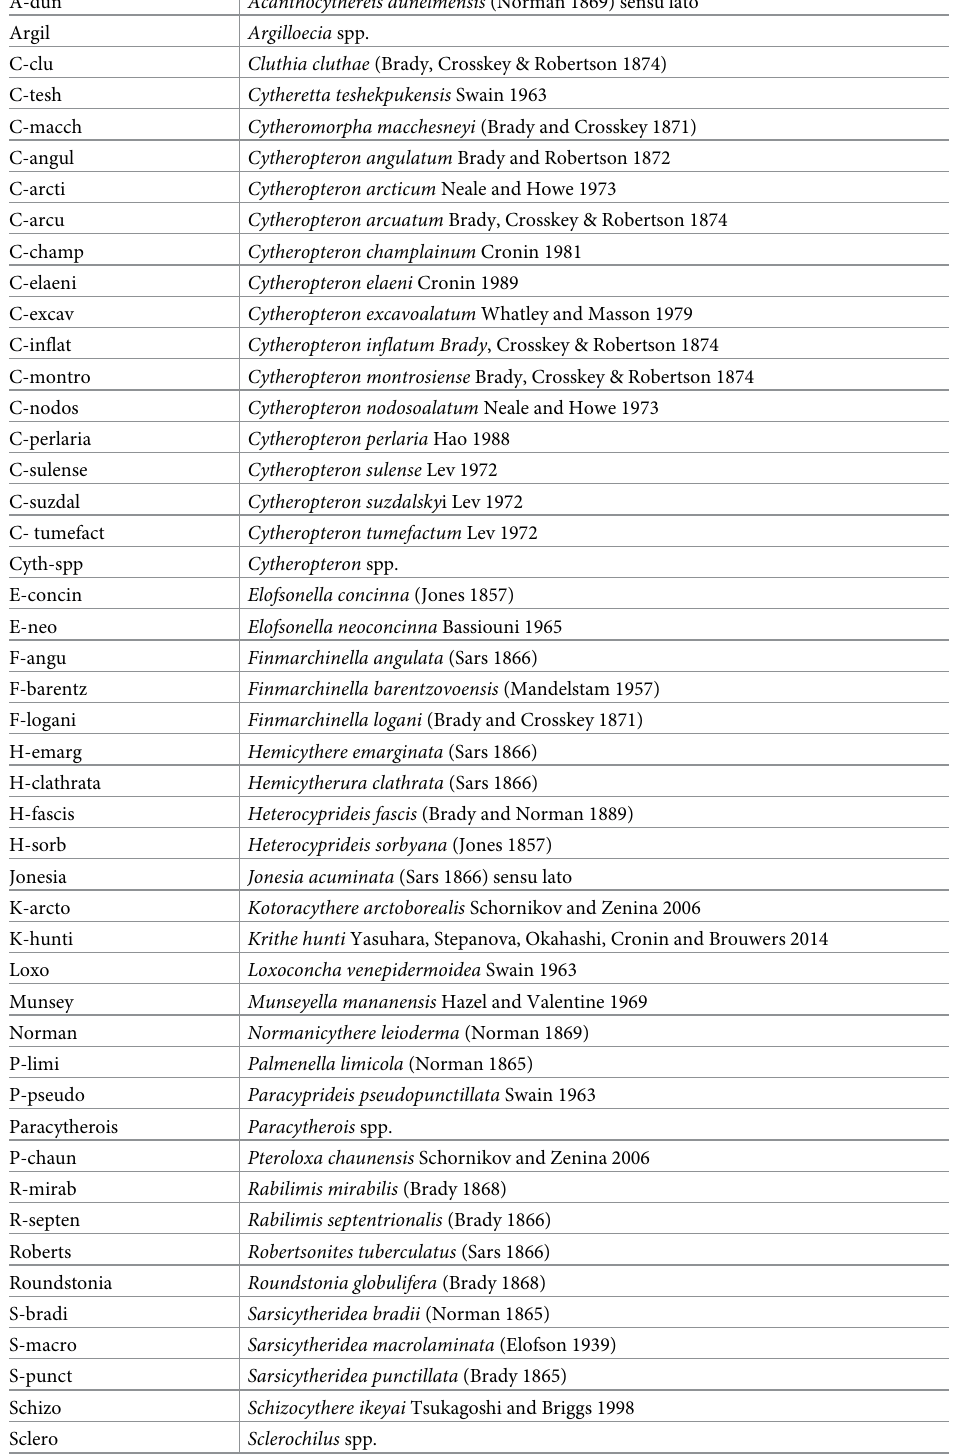
Table 2. List of 47 species and five genera found in the study region ( � 1% of cumulative assemblage and/or occurred in 5 or more